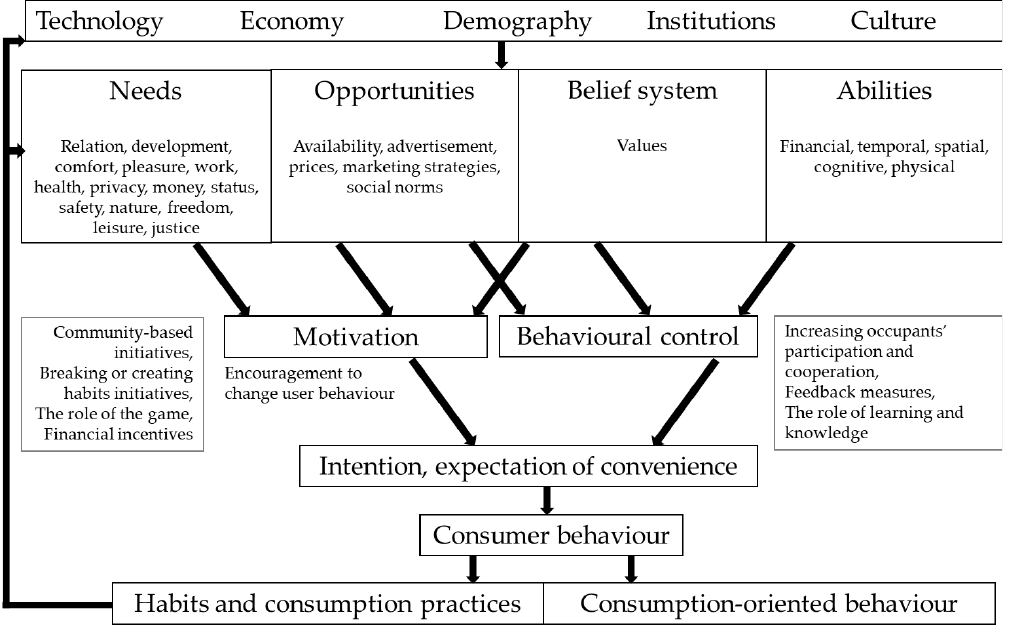
Figure 5. Model of effective factors on the emergence of consumer behaviours (Adapted from the NOA model [133, 137, 154].